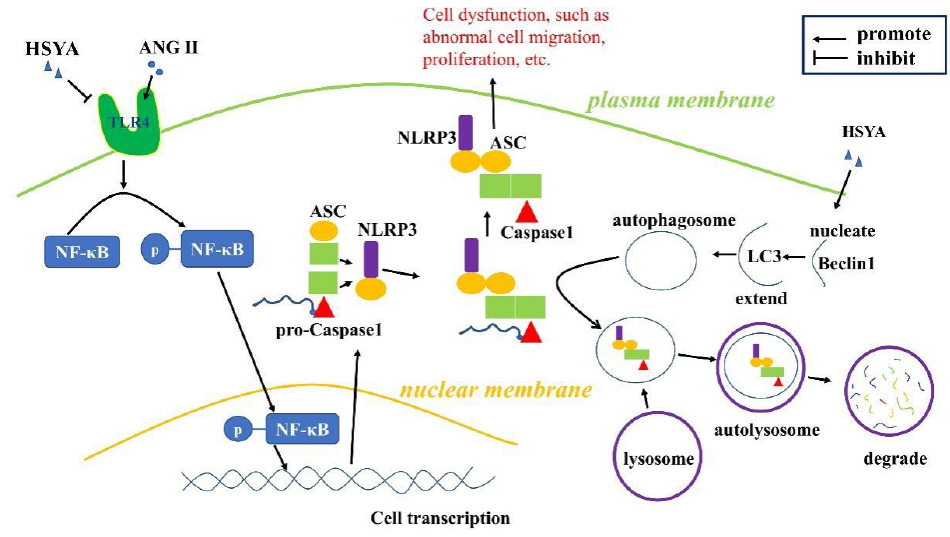
Figure 5. A proposed model that illustrates how HSYA induces autophagy and inhibits NLRP3 inflammasomes through the TLR4/NF- κ B signaling pathway.